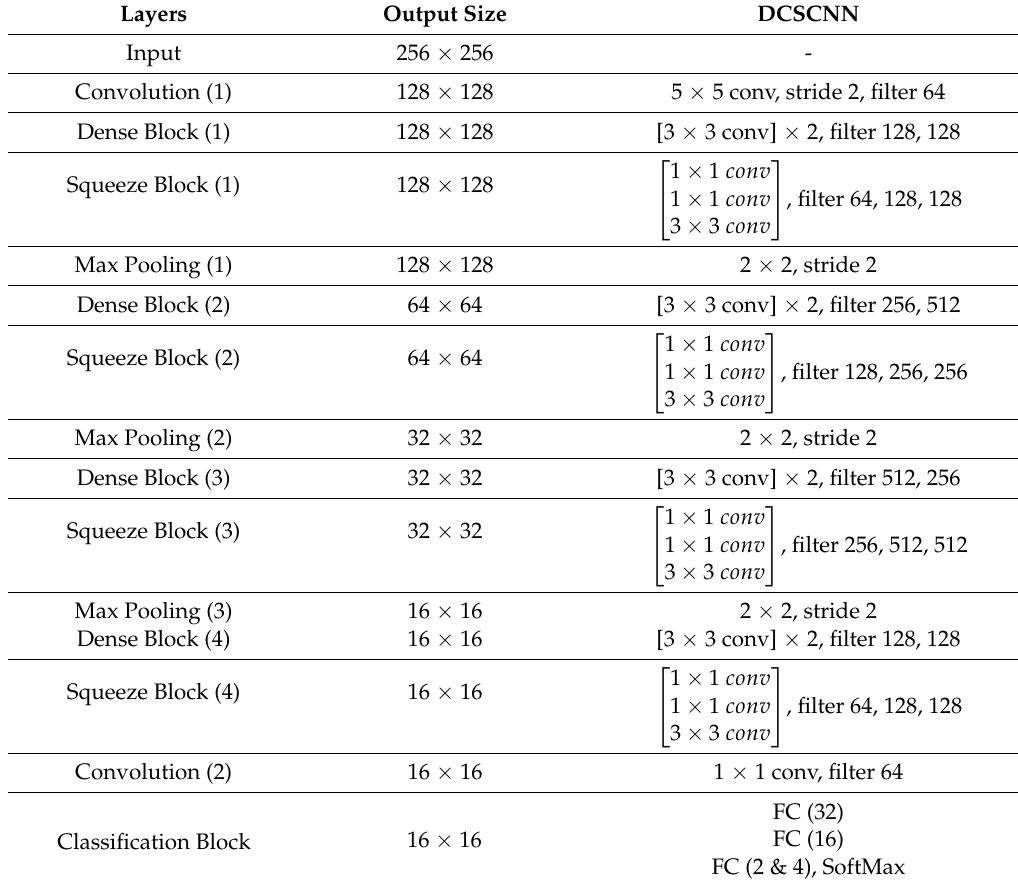
Table 2. Specification of DCSCNN